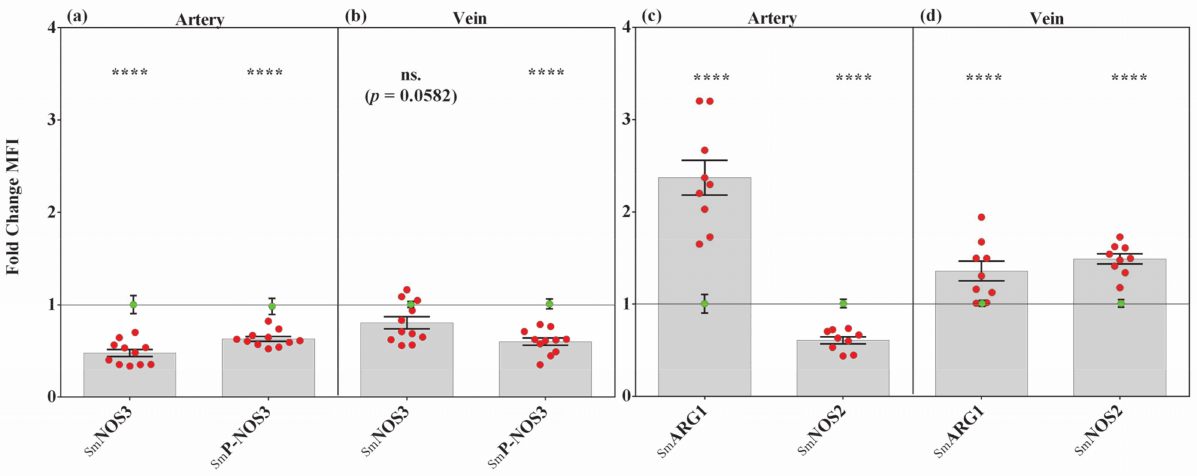
Figure 3. Changes of NO synthesis determining factors in Sm-derived UC vessels. Bar graphs showing the semiquantified results of NOS3-, P-NOS3-, ARG1- and NOS2-specific immunolabeling in Sm arteries ( a , c ) and in Sm veins ( b , d ). Red dots symbolize the overall MFI values from individual Sm samples, while green dots refer to the summarized data from the Ctrl group, applied as the baseline of comparison (mean ± SEM). Sample numbers: CtrlNOS3 ( n = 95 artery and 112 vein ROI from 12 individual samples); SmNOS3 ( n = 53 artery and 102 vein ROI from 11 individual samples), CtrlARG1 ( n = 77 artery and 781 vein ROI from 10 individual samples); SmARG1 ( n = 64 artery and 732 vein ROI from 9 individual samples); CtrlNOS2 ( n = 211 artery and 130 vein ROI from 11 individual samples); SmNOS2 ( n = 100 artery and 243 vein ROI from 9 individual samples). Statistics: unpaired t -test followed by Mann–Whitney test to compare ranks ns. = non-significant, **** p ≤